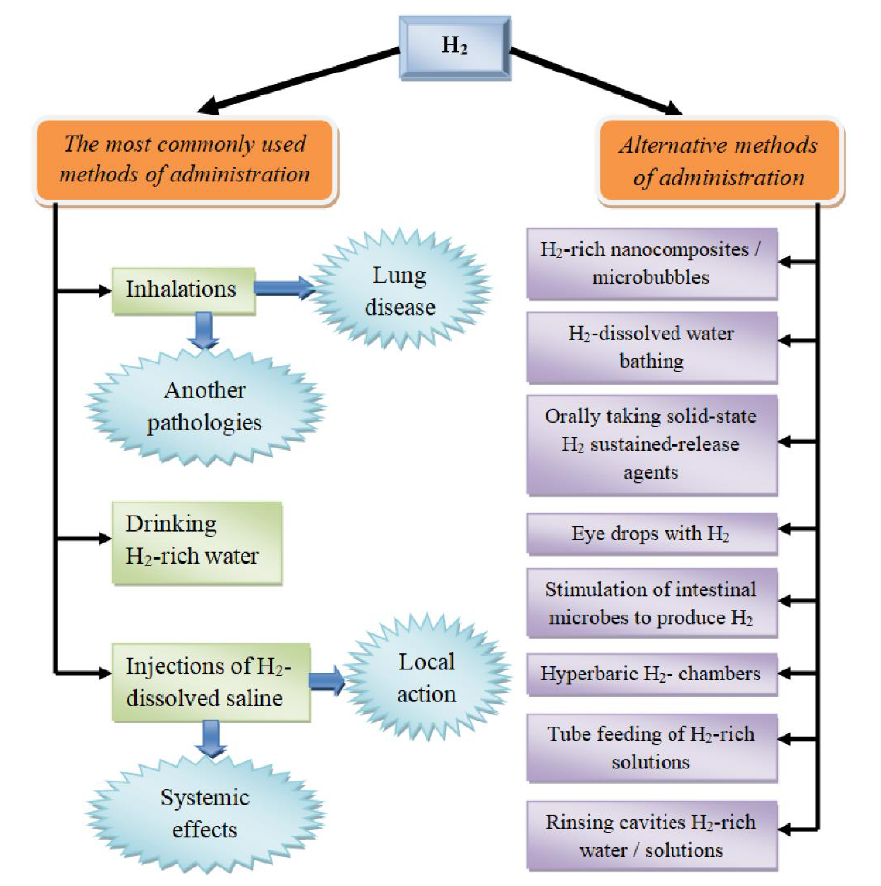
Figure 2. Routes of molecular hydrogen administration.